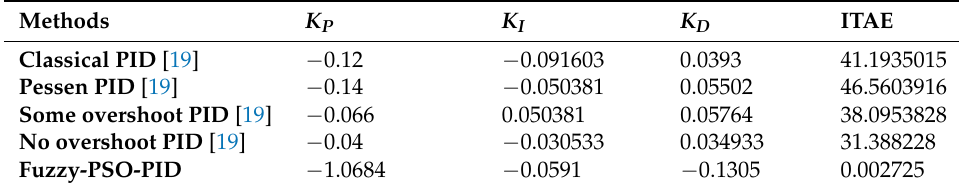
Table 2. Numerical outcomes of the Fuzzy-PSO PID.